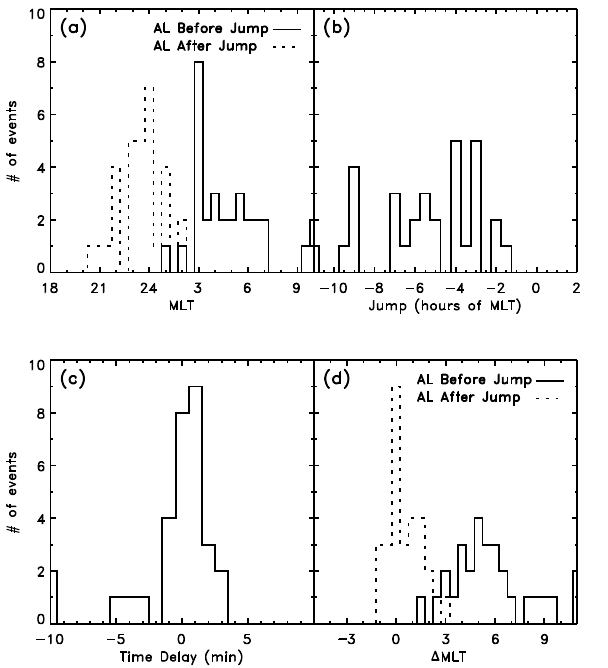
Fig. 3. Panels (a) through (d) are all related to the expansion phase onset associated westward AL jump. Panel (a) shows the distribu- tions of the location of the AL defining station before and after the jump; panel (b) shows the change in location (position after jump, minus position before jump); panel (c) shows the onset time minus the AL jump time; and panel (d) shows the same as (a) but as a function of distance to onset.